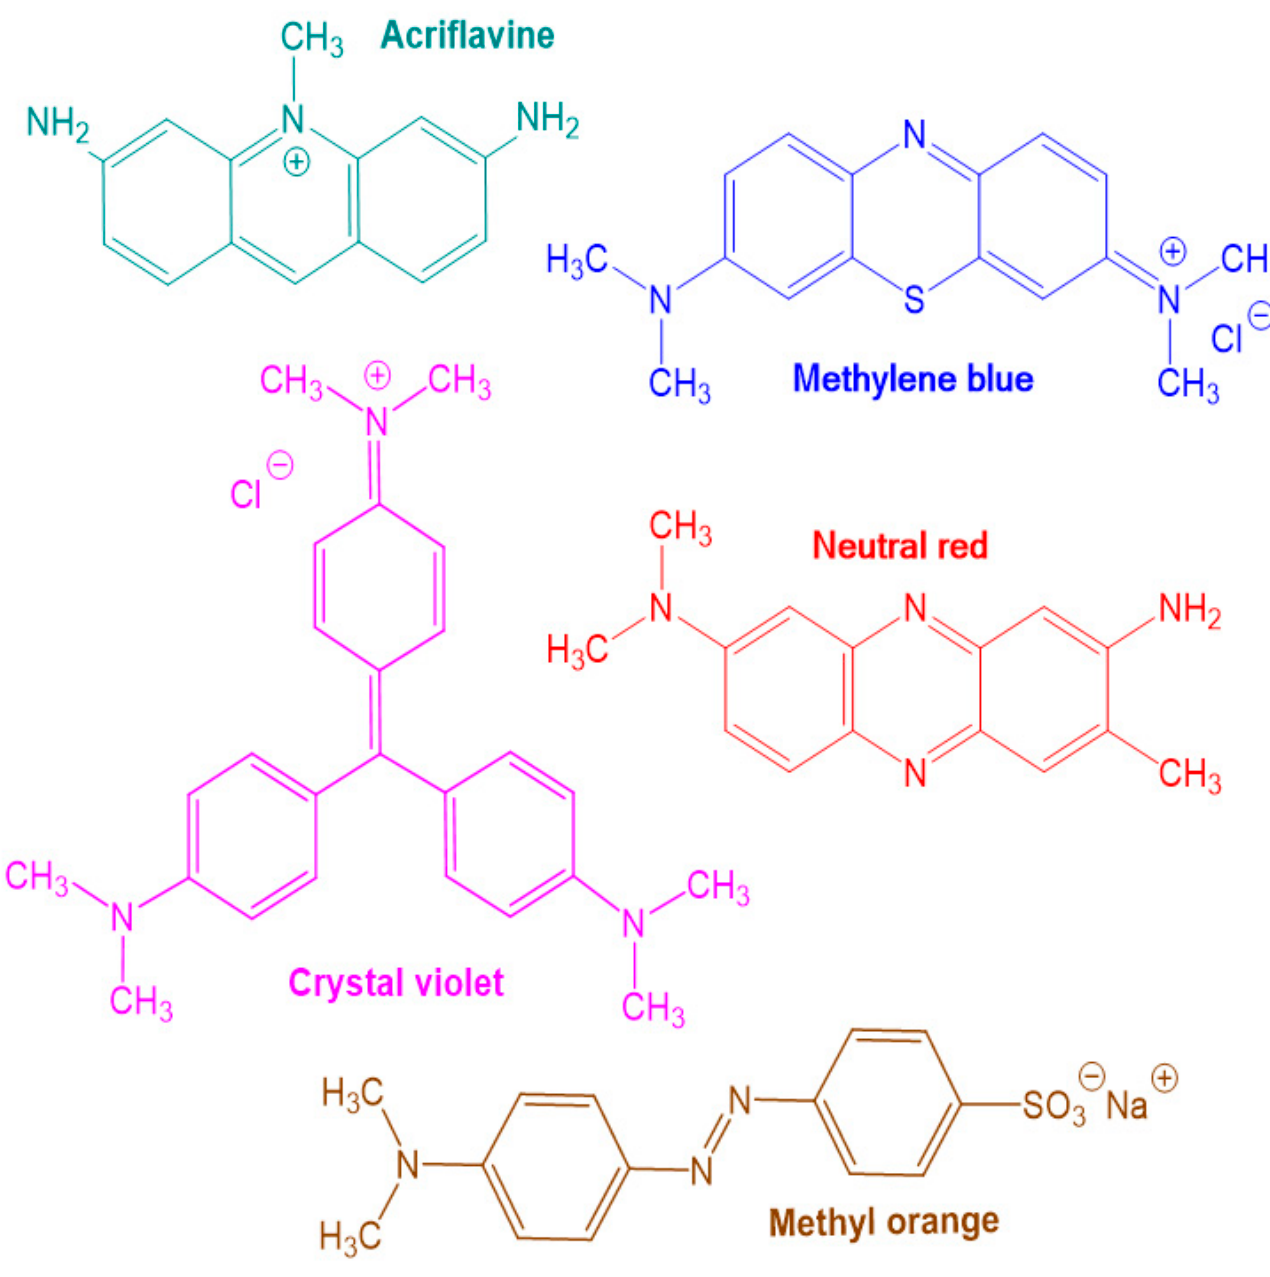
Figure 2. Molecular structure of organic dyes: acriflavine, methylene blue, crystal violet, neutral red, and methyl orange.